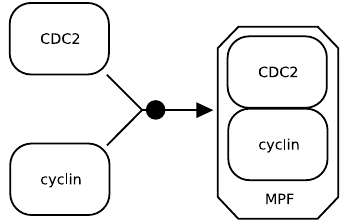
Figure 2.34: The Process Description glyph for association .